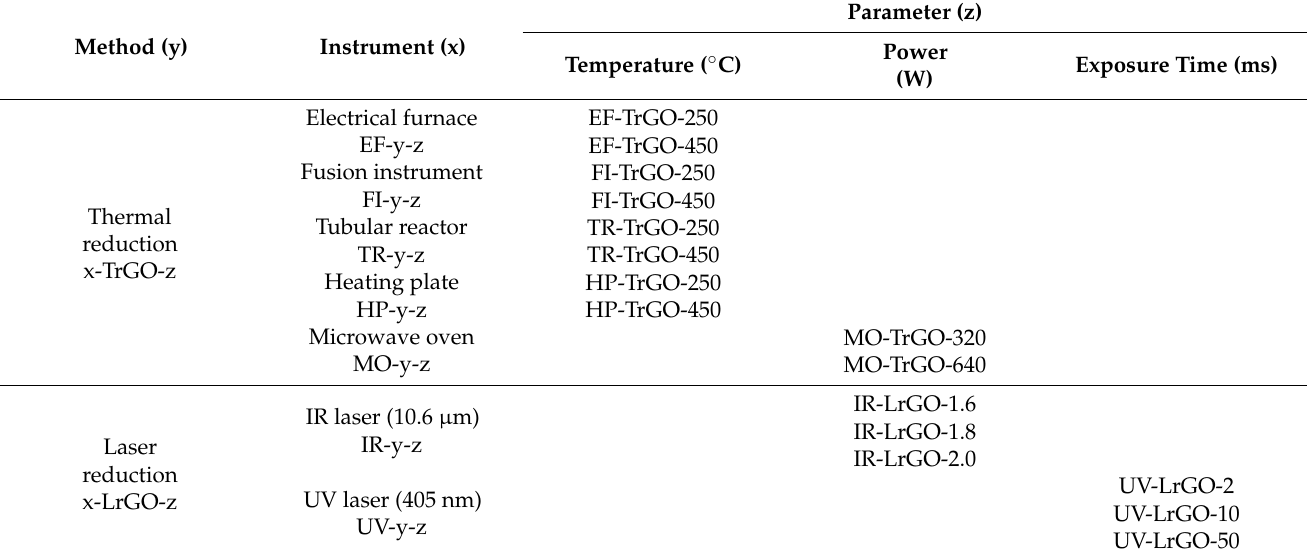
Table 1. Nomenclature of the rGO samples.